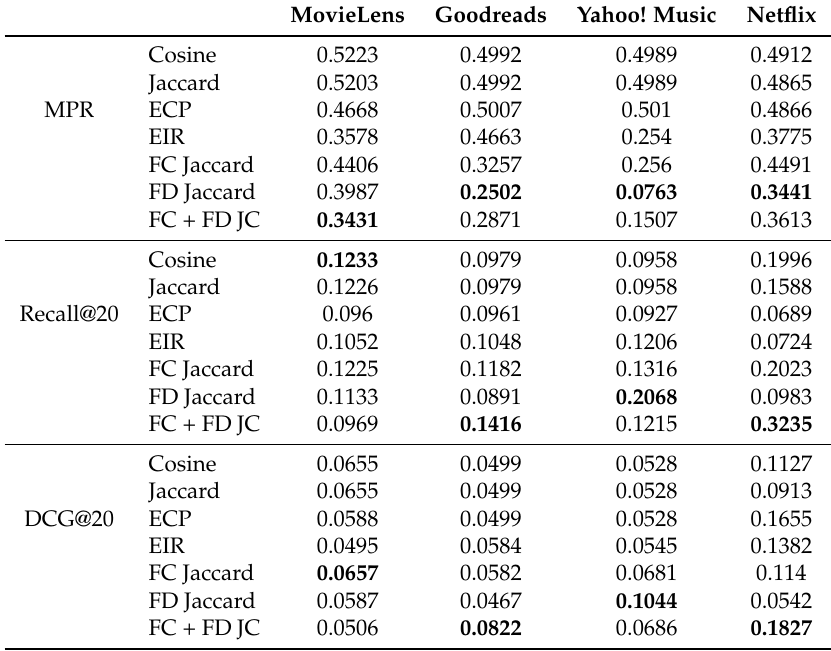
Table 11. Experiments over the first three quantiles (based on KDE estimations of 75%). Best performing methods are indicated in